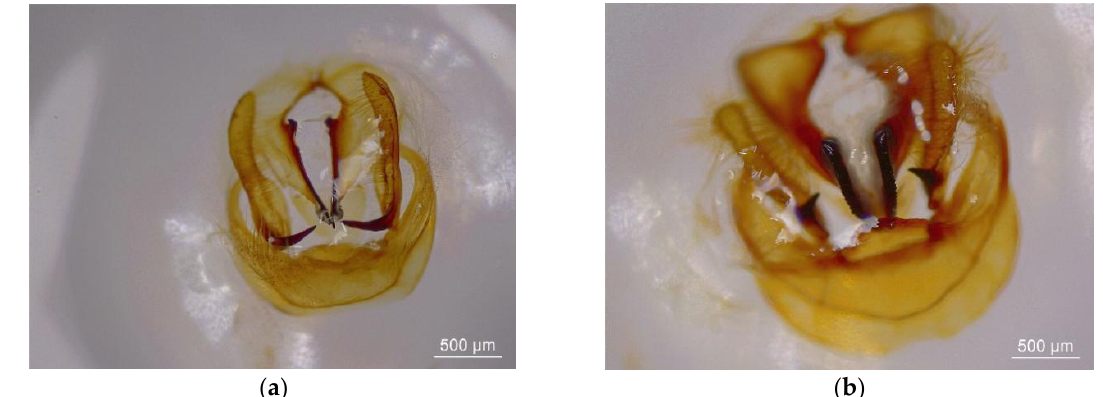
× SD ) ( a ) and Thitarodes shambalaensis (GG ♀ ♂